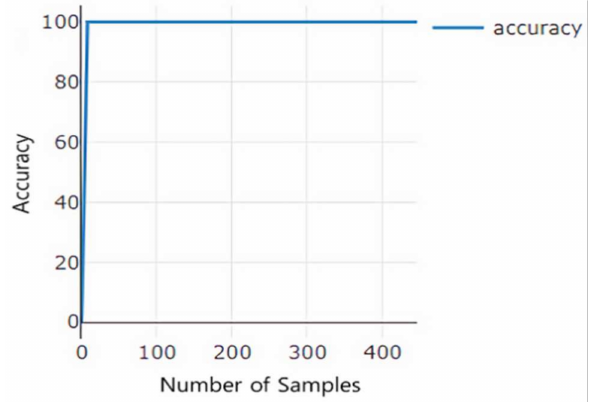
Figure 11. Accuracy of test of the first data